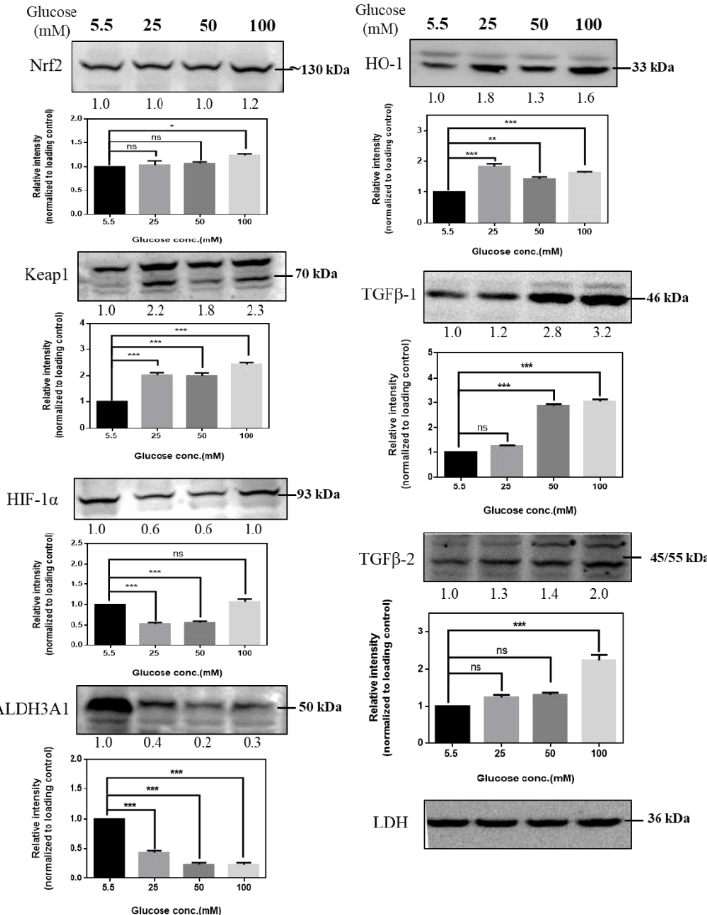
Figure 2. Immunoblot analysis of RGCs with hyperglycemia. Immunoblot analysis of antioxidation